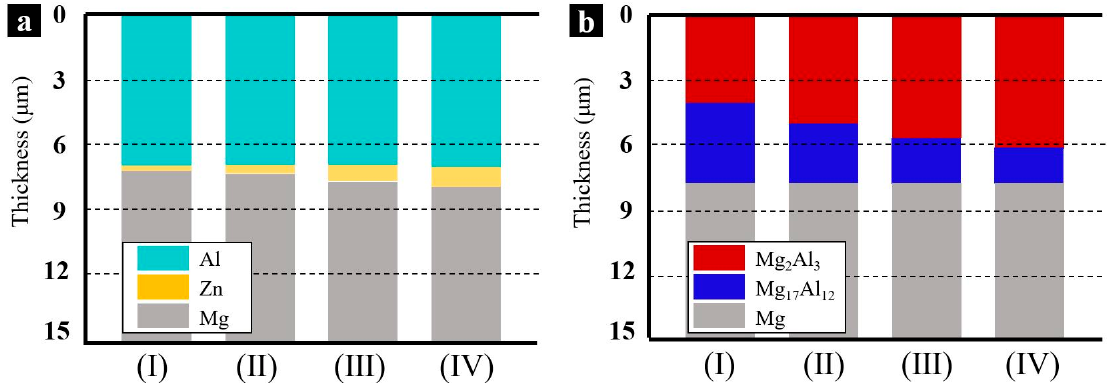
Figure 8. The thickness variations of the intermetallic compounds β -phase (Mg 17 Al 12 ) and γ -phase (Mg 2 Al 3 ) with various Zn immersion times (I) 2 min, (II) 4 min, (III) 6 min, and (IV) 8 min. ( a ) electrodeposition Al coatings obtained on the AZ91D Mg alloy, ( b ) the Al coatings after a 350 °C heat treatment for 4 h